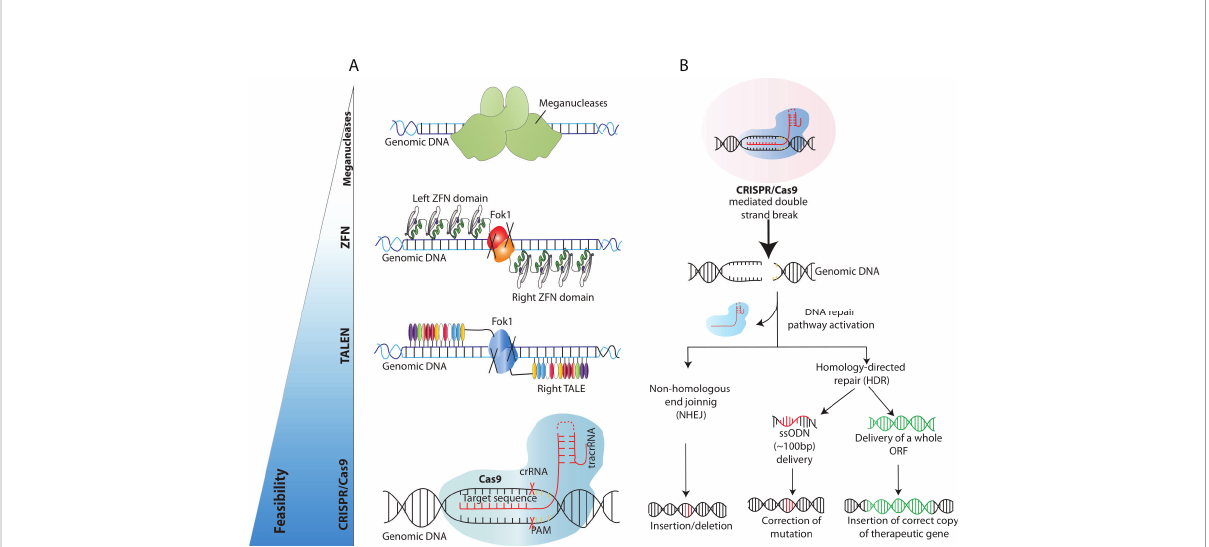
FIGURE 3 Overview of the existing engineered nucleases platforms and main DNA double-strand breaks repair mechanisms exploited for gene correction. (A) Schematics of the different programmable nucleases that have been developed so far (B) Engineered nucleases (CRISPR/Cas9 in this case) create DNA double-strand breaks at the genomic site of choice. DNA double strand break repair proceeds either through the non-homologous end joining (NHEJ) or Homology Directed Repair (HDR) pathway. In the NHEJ pathway, random insertions and deletions (indels) are introduced at the cut side and ligated resulting in error-prone repair. In the HDR pathway, the homologous chromosomal DNA exogenously provided serves as a template for the damaged DNA during repair, resulting in error-free correction of a disease-causing mutation if a short ssODN is provided and/or high- fi delity insertion of new genomic sequences, when, for example, a full-length open reading frame (ORF) is